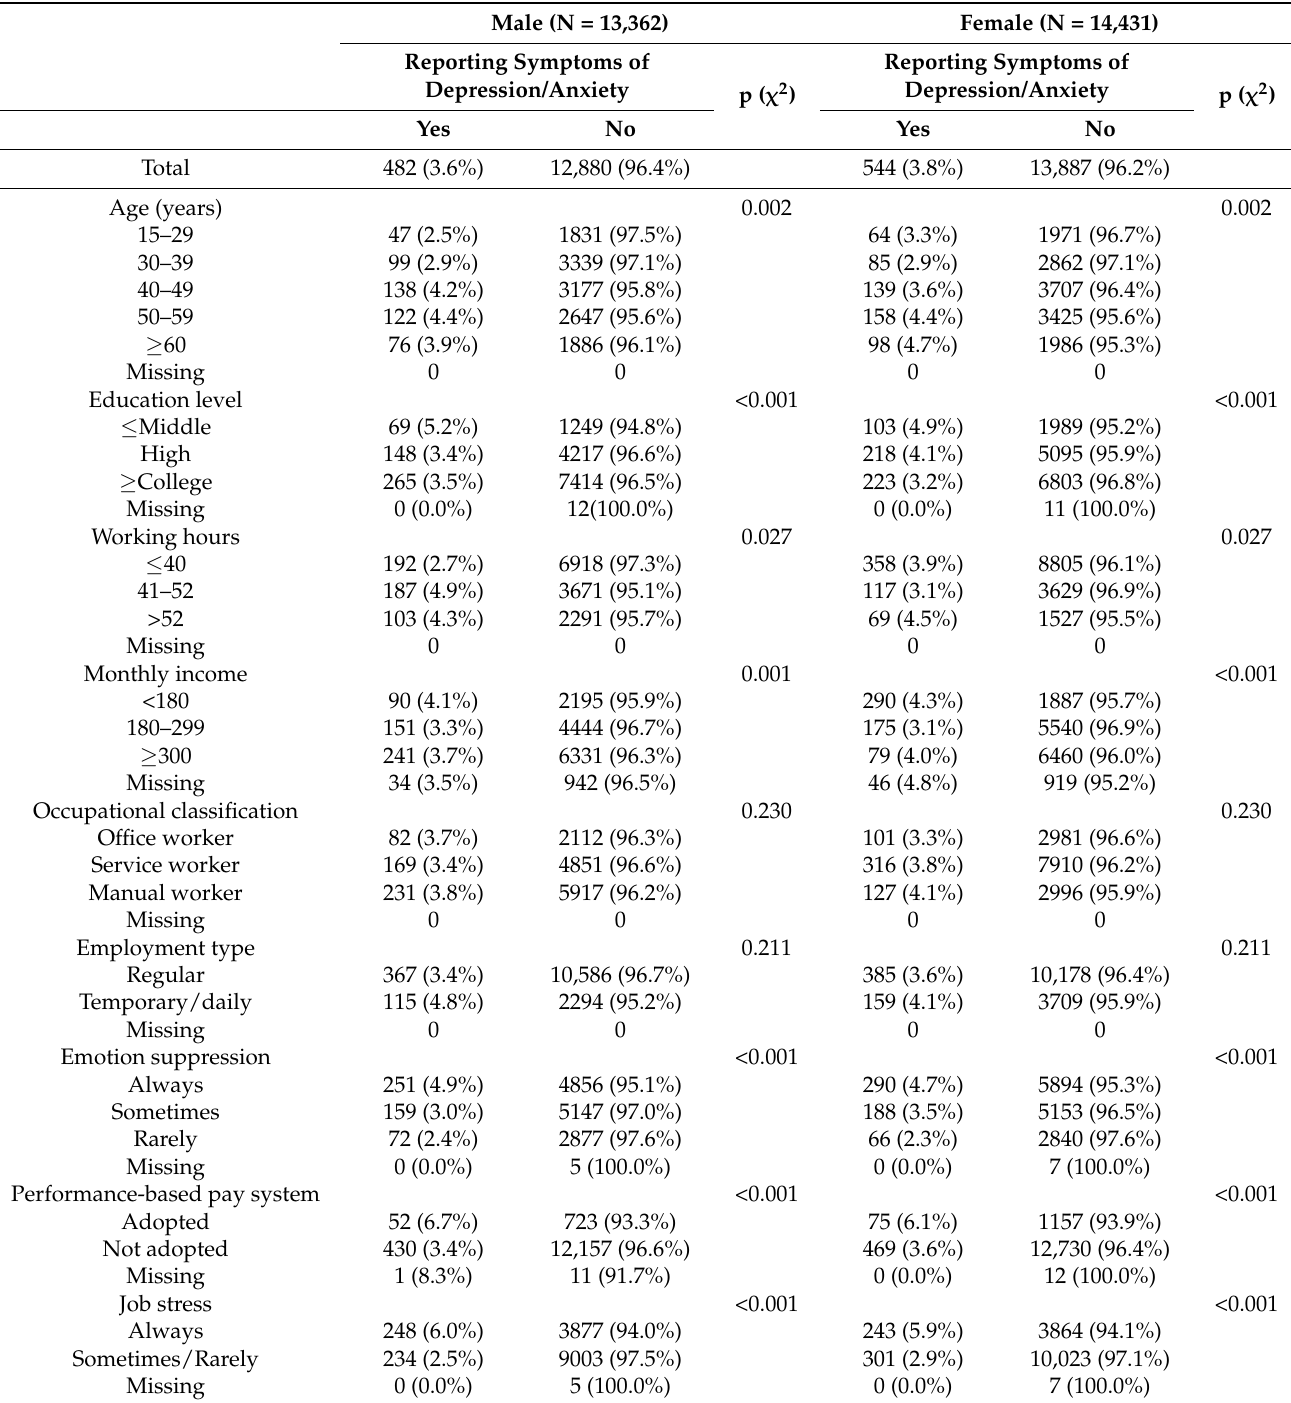
Table 2. General characteristics of the study population based on reporting symptoms of depres- sion/anxiety and demographic